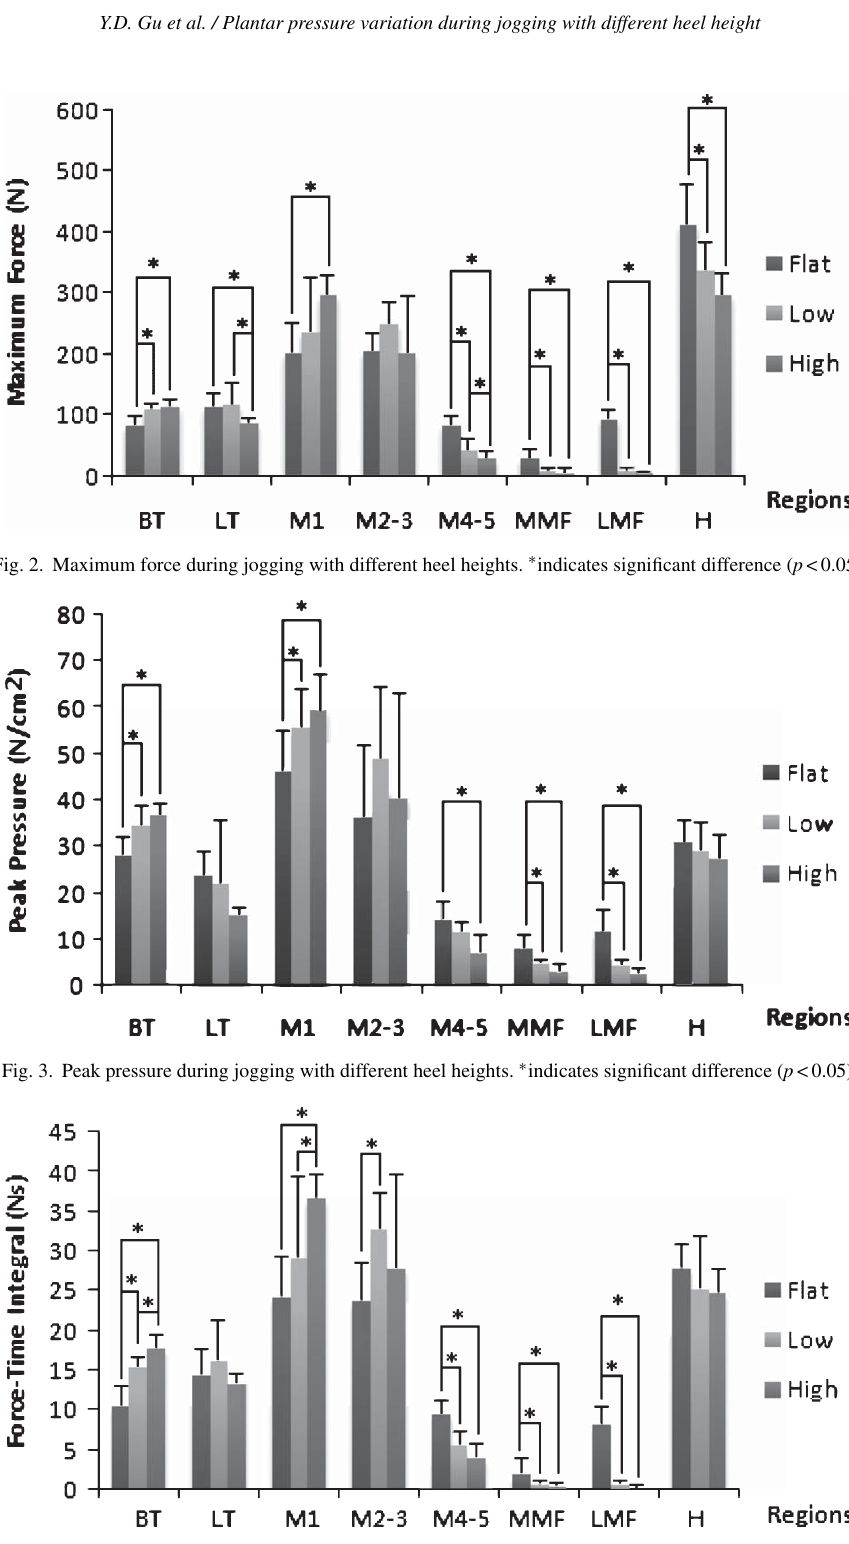
Fig. 4. Force-time integral during jogging with different heel heights. ∗ indicates significant difference ( p